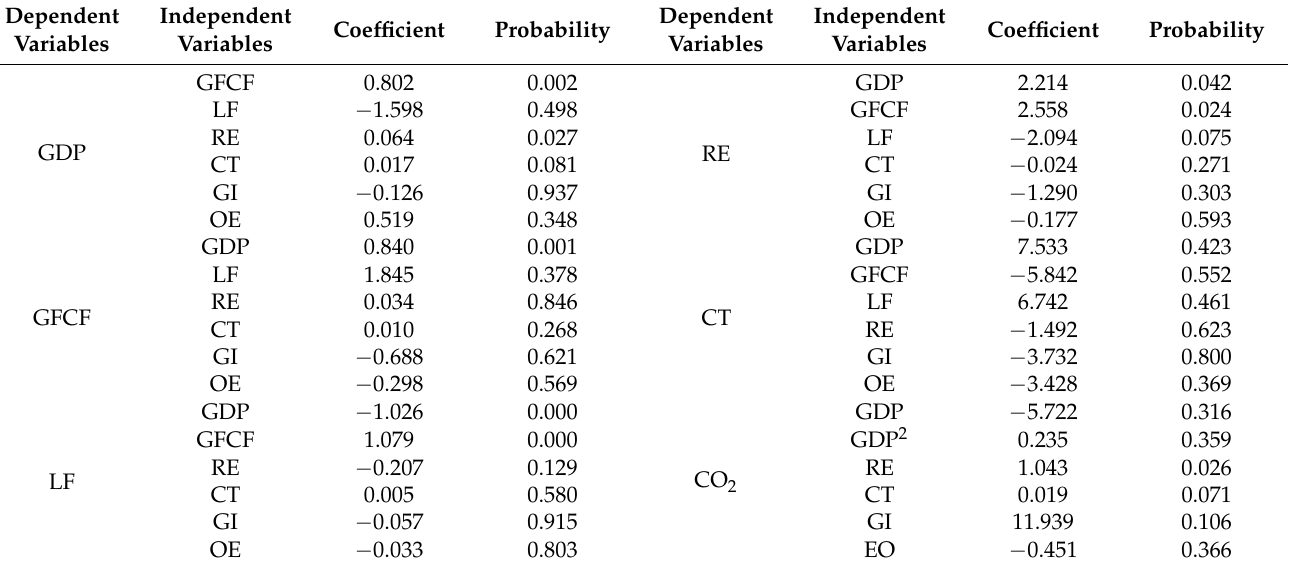
Table 6. The findings of the FMOLS panel cointegration technique.